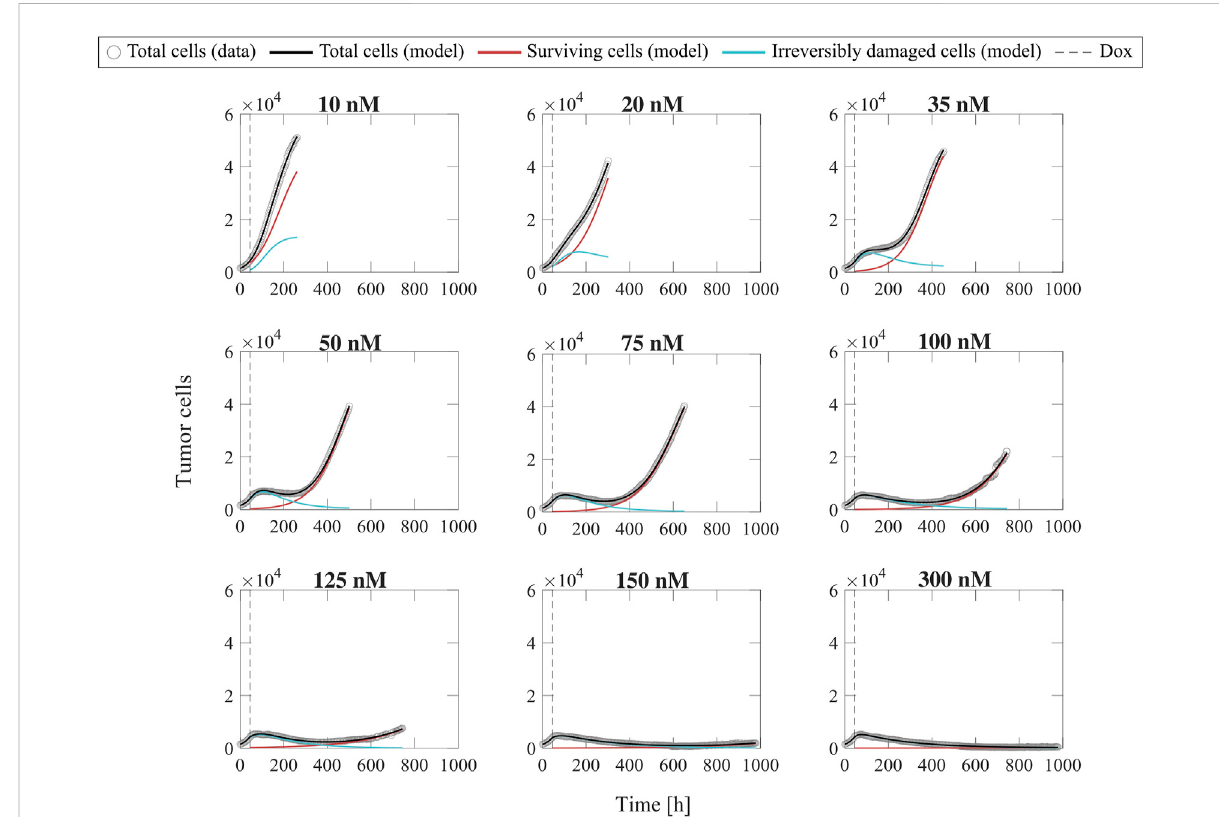
FIGURE 2 Representative fi ts of the single-dose model for varying concentrations of doxorubicin. Data and model fi ttings are shown for a representative replicate treated with 10 – 300 nM doxorubicin concentrations (Experiment 1, Table 1). Experimental data are shown in gray circles. The number of total cells, surviving cells, and irreversibly damaged cells obtained with the fi tted single-dose model are shown in black, red, and blue solid lines, respectively. The time of doxorubicin delivery (Dox) is represented with a vertical grey dashed line. As doxorubicin concentration is increased, we observe a decrease in the growth rate of surviving cell subpopulation and a faster transition from growth to treatment-induced death in irreversiblydamagedcell subpopulation. Thesedrug-induced effectsultimatelytranslateintoalonger delay(oreven